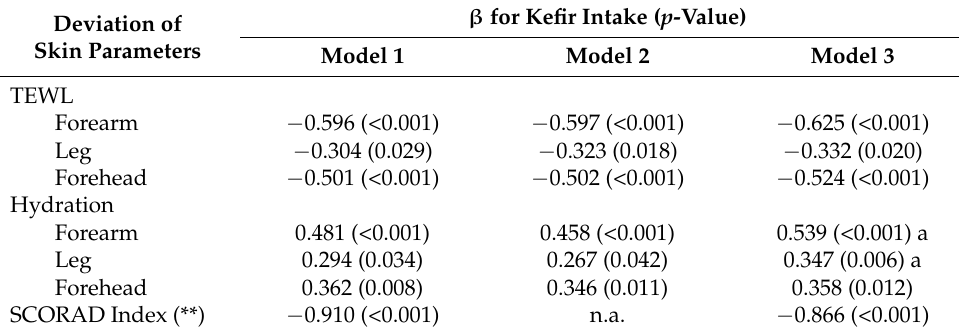
Table 6. Multiple linear regression for effect of kefir status on skin parameters (standardized regres- sion coefficient ß ( p -value), n =